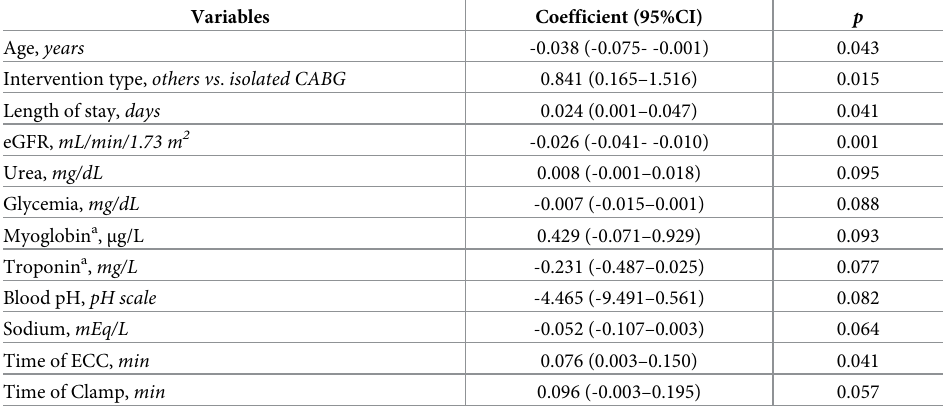
Table 3. Univariate logistic regression analysis for acute kidney injury (AKI) in patients undergoing cardiac surgery.